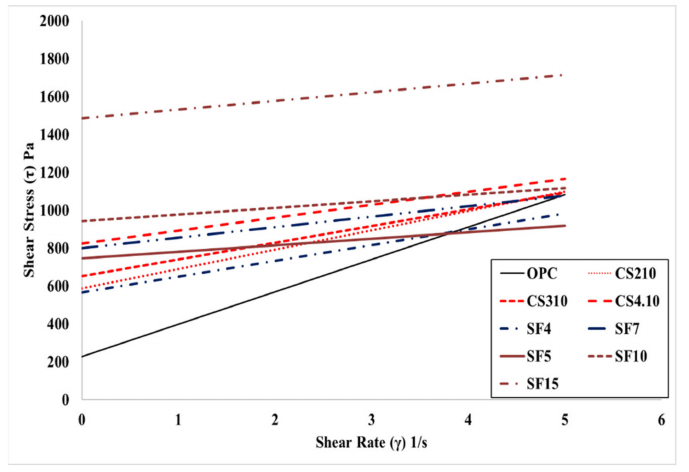
Figure 21. Bingham model result comparison of all mixing ratios (own results and Jeon’s indicated with SF5, SF10, and